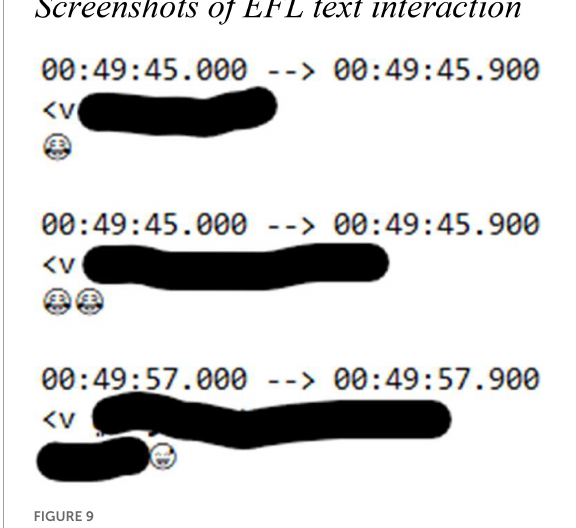
TABLE 3 Sense of virtual community (SOVC) questionnaire